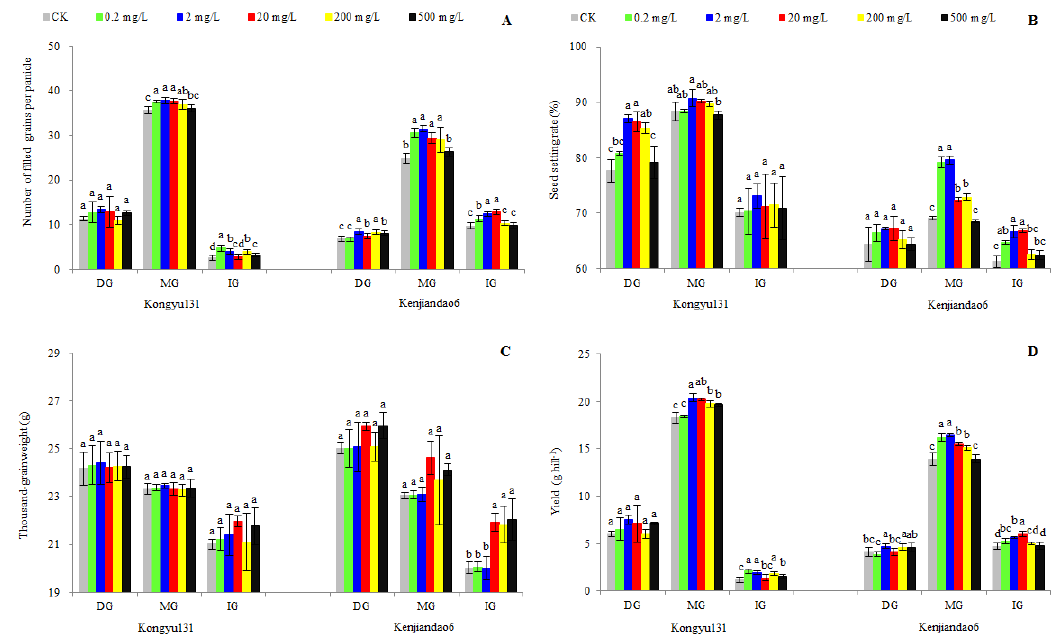
Figure 4. Effects of yield components and yield under diethylaminoethyl hexanoate (DA-6) treat- ment in the inferior grains (IG), middle grains (MG), and dominant grains (DG) under cold water stress (CWS) on both cultivars. The letters above the columns indicate significant differences ( p < 0.05). ( A ) Number of filled grains per panicle, ( B ) Seed setting rate, ( C ) Thougand-grain weight, ( D ) Yield.